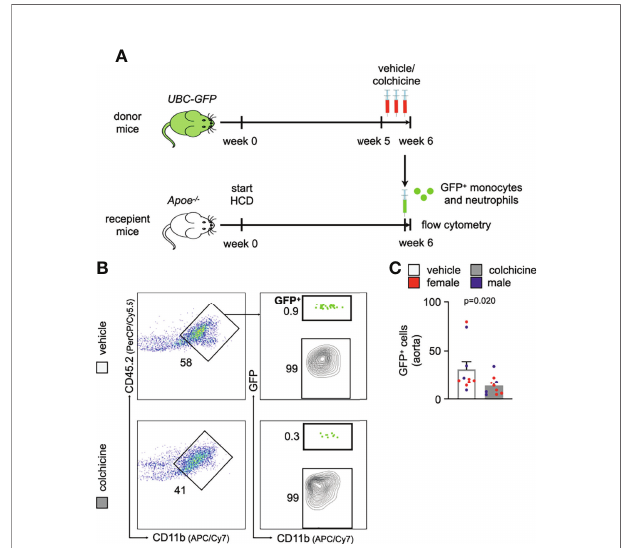
FIGURE 3 | Colchicine exposed neutrophils and monocytes show reduced recruitment capacities. (A) Experimental scheme. (B) Flow cytometric gating and (C) quanti fi cation of GFP high myeloid cells (GFP + ) in atherosclerotic aortas 24h after adoptive transfer of either vehicle- or colchicine-exposed GFP high monocytes and neutrophils into Apoe -/- mice ( n =10 per group, 60% female, Mann-Whitney U -test). Data are presented as mean+s.e.m. Numbers next to gates indicate population frequencies (%). Dots within bar plots show the gender of the mice with a color code: purple (male) and red